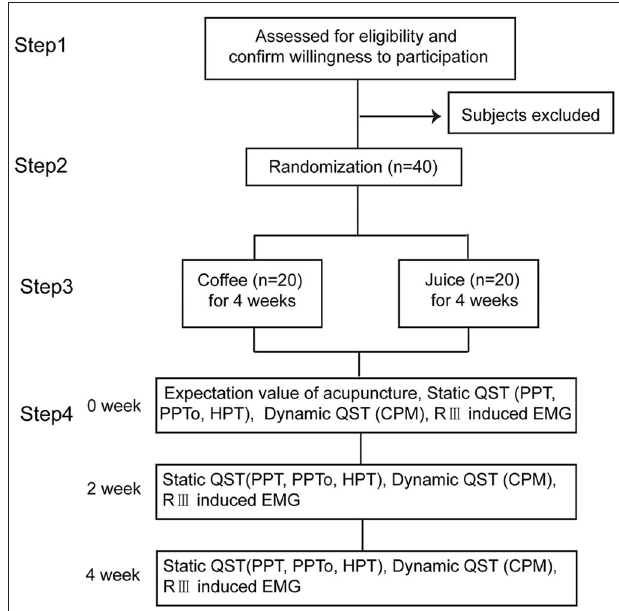
FIGURE 1 | Study design. The participants are randomized in a 1:1 ratio to either the juice or coffee group. The static QST, dynamic QST, and RIII induced EMG are measured before and after acupuncture and at 2 and 4 weeks after intervention in each